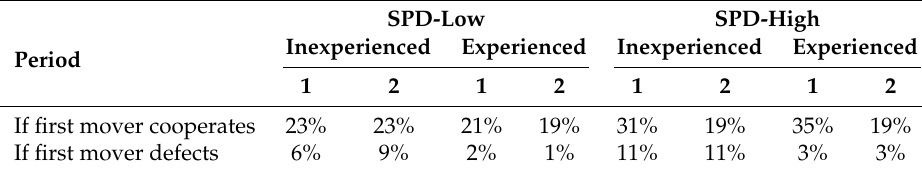
Table 2. Cooperation rates for inexperienced and experienced second